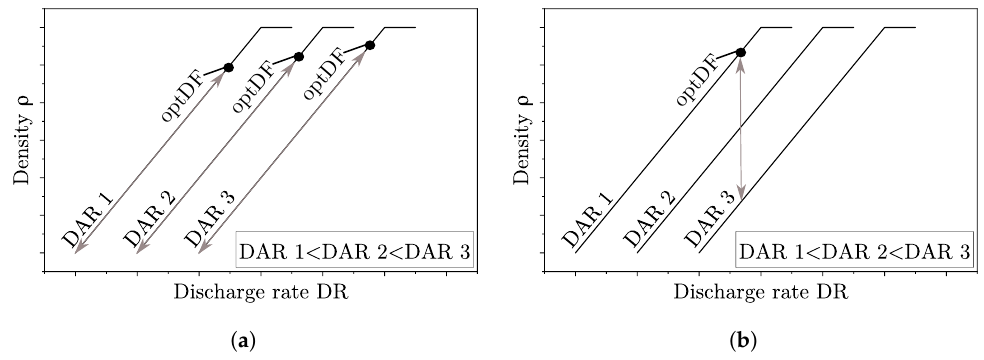
Figure 12. Comparison of the existing approach for parameter determination for optDF with the approach used in this work. The objective is presented in a qualitative diagram with constant LT that relates the density of a part and the DR. ( a ): Approach used in this work. ( b ): Existing